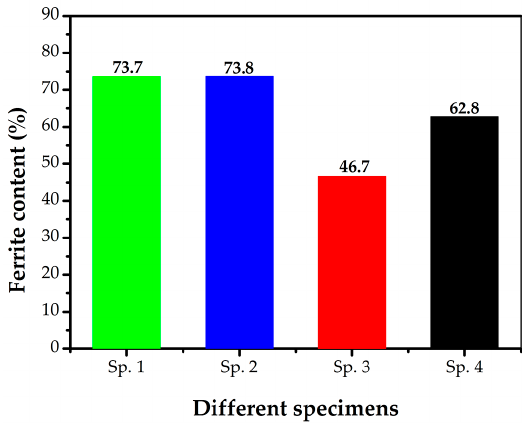
Figure 7. Ferrite contents of different specimens.